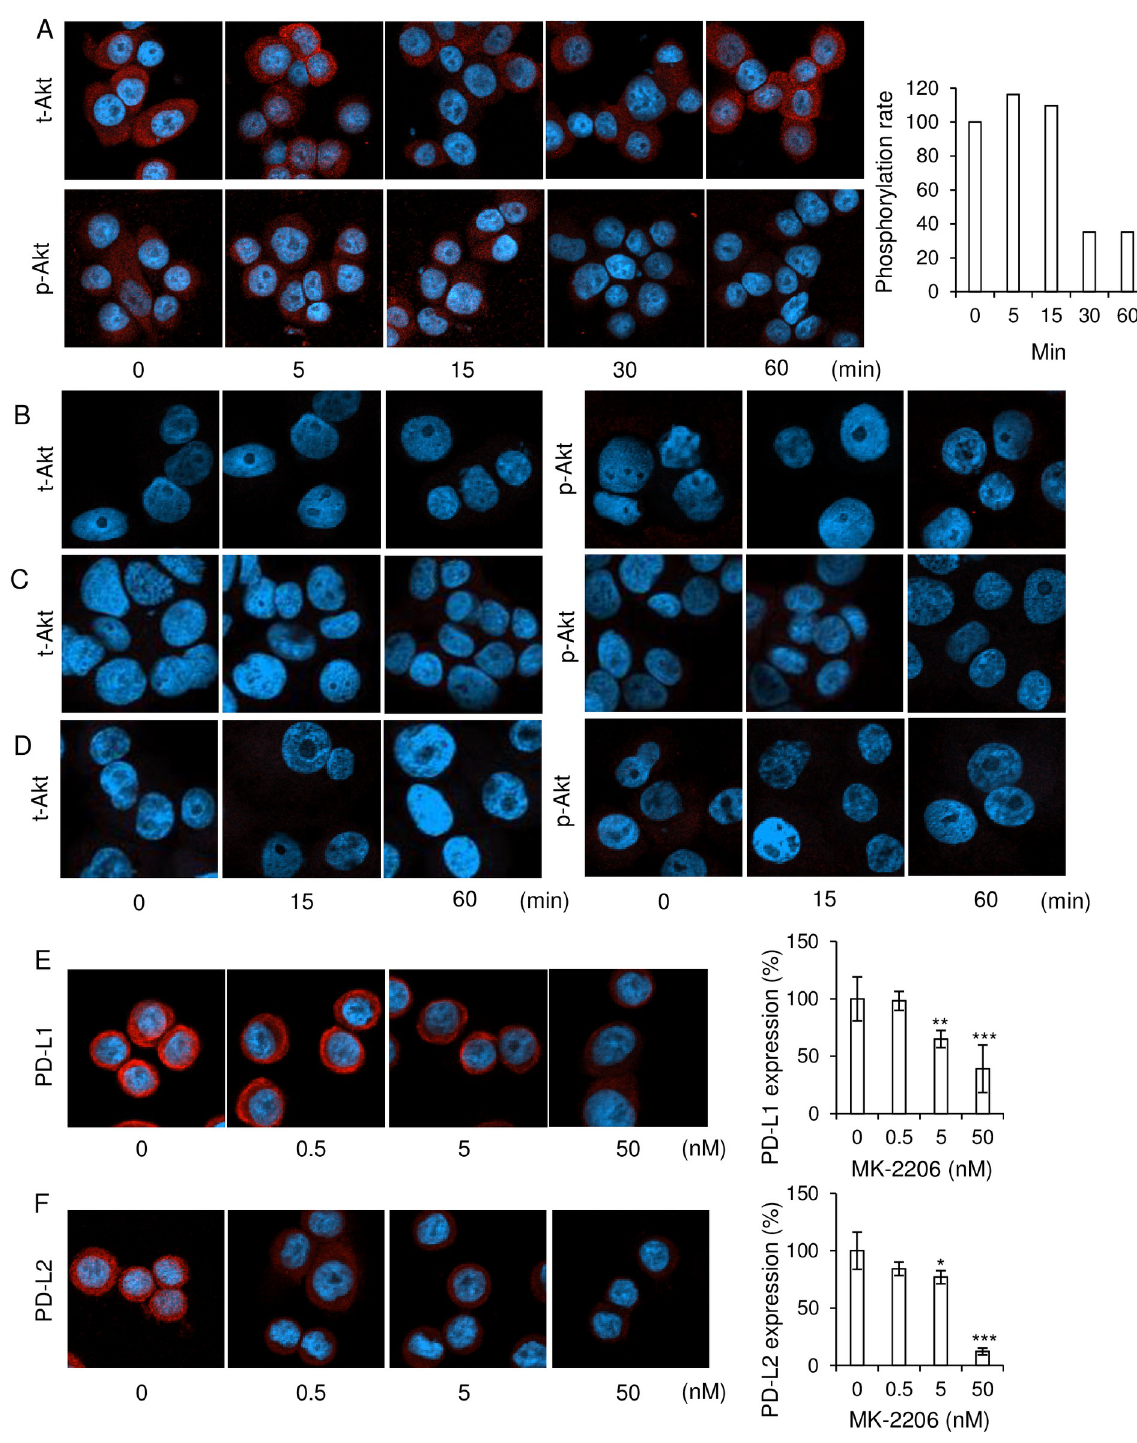
Fig 5. Nicotine decreased Akt phosphorylation in SK-BR-3 cells. (A) Akt expressions and the phosphorylation in nicotine-treated SK-BR-3 cells were assayed by immunostaining. SK-BR-3 cells were stimulated with 100 nM nicotine for indicated time and the cells were stained with indicated antibodies (red). DAPI (blue) was used for detecting nuclei. Some of representative figures of total-Akt (upper), phosphorylated Akt (lower) are shown. The relative phosphorylation intensity of Akt was calculated using ImageJ (n = 5–7 each). (B-D) Akt expressions and the phosphorylation in nicotine-treated MCF8 (B), HCC1937 (C) and MDA-MB-231 (D) cells were assayed by immunostaining. SK-BR-3 cells were stimulated with 100 nM nicotine for indicated time and the cells were stained with indicated antibodies (red). DAPI (blue) was used for